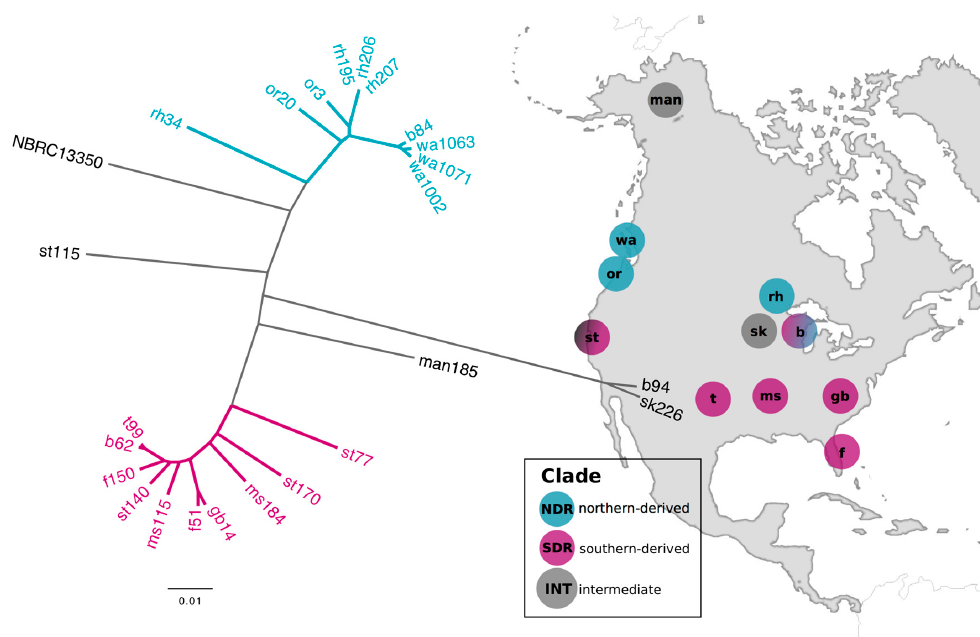
Figure 1. The northern-derived (NDR) and southern-derived (SDR) clades are closely related sister-taxa and yet were isolated from soils of different latitude. The un-rooted tree was constructed from multiple whole genome alignments with maximum likelihood and a GTRGAMMA model of evolution. Scale bar represents nucleotide substitutions per site. Colored branches depict the northern-derived (NDR) and southern-derived (SDR) clades. Strain names reflect the sample site they were isolated from (Table S1). Genome NBRC 13350 is the publically available type strain Streptomyces griseus subsp. griseus NBRC 13350. Sample locations are shown in the right panel and labeled with the site code. Circles are colored to reflect the geographic distribution of clades. (Figure modified from [29]).